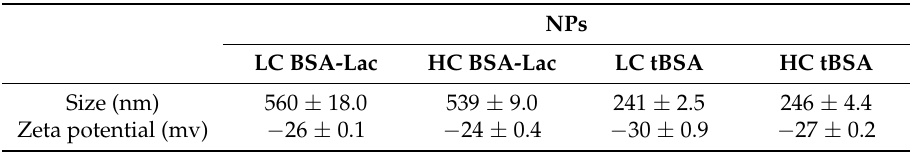
Table 1. Size and zeta potential of low-crosslinking (LC) BSA-Lac, high-crosslinking (HC) BSA-Lac, LC tBSA, and HC tBSA nanoparticles